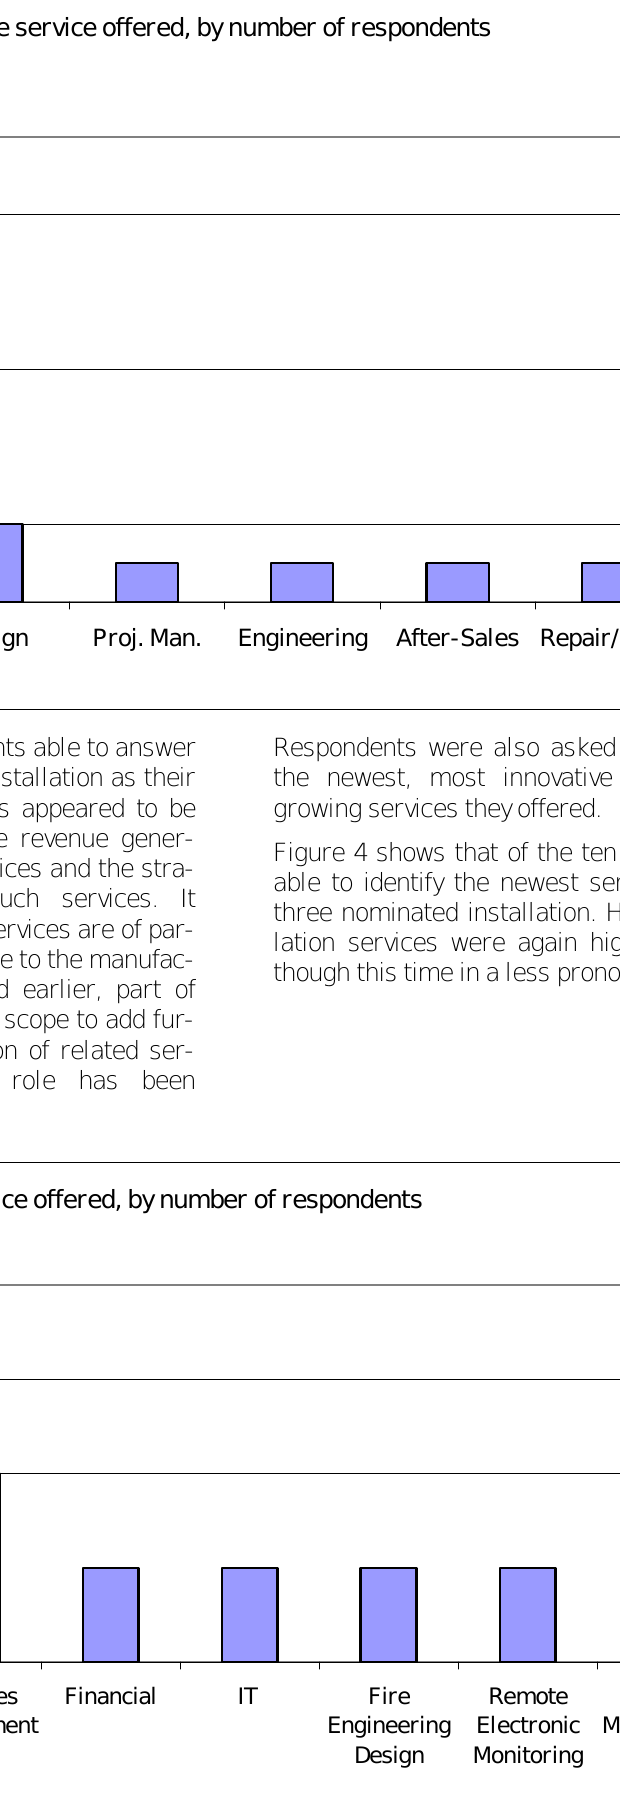
Figure 3: The highest value service offered, by number of respondents